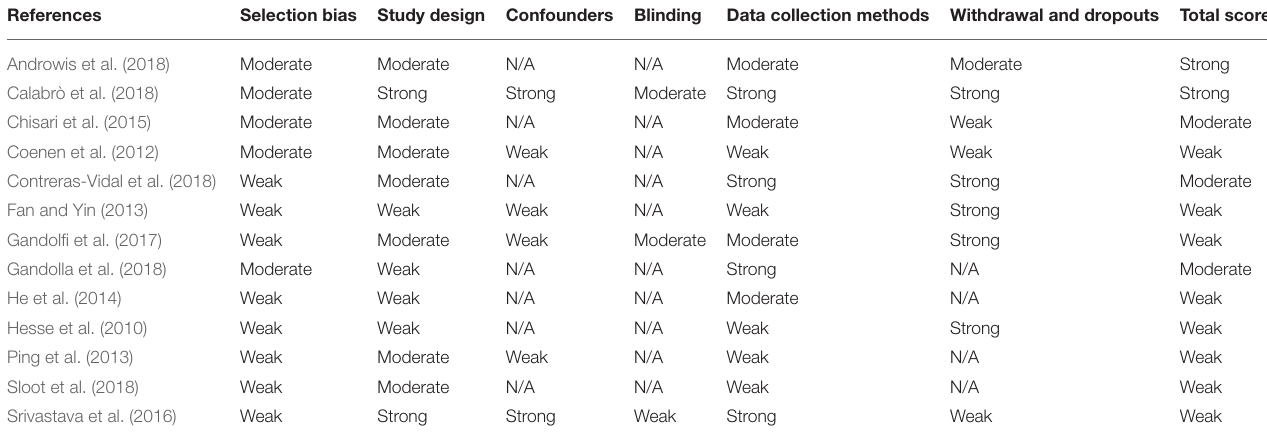
TABLE 5 | Quality rating of included